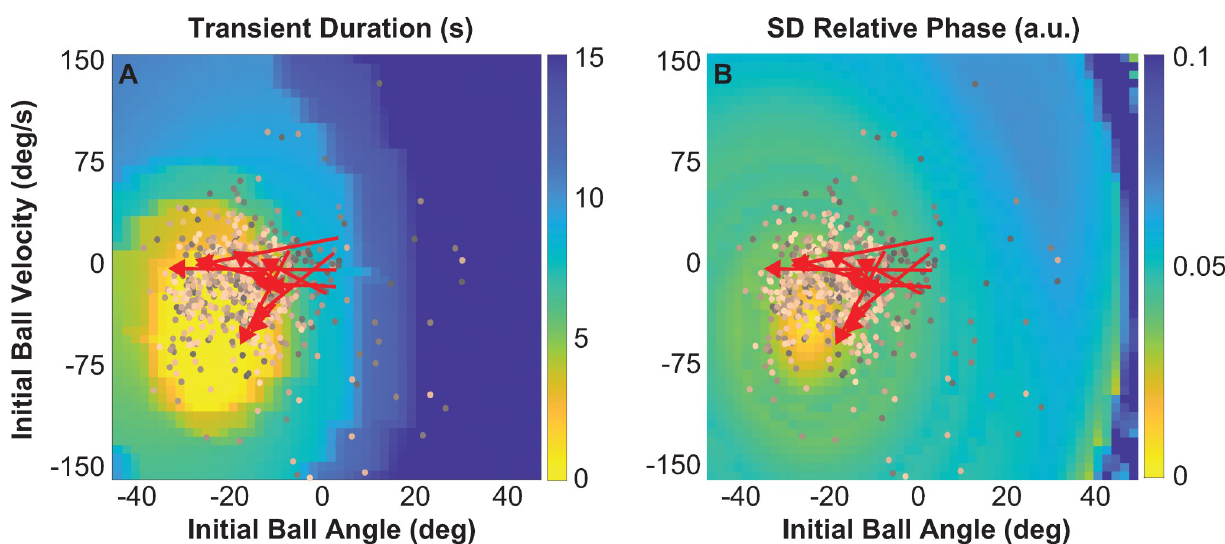
Fig 9. Predicted effect of initial ball states on transient duration and stability of the steady state: Simulated results for transient duration and variability of relative phase during steady state. The results were generated by forward simulations using an impedance controller for different initial ball angles and velocities; the impedance parameters were: K = 40 N/m and B = 40 Ns/m; cup frequency was fixed at 0.58 Hz. In the simulated maps experimental data of ball angles and velocities from all 1100 successful trials are overlaid; darker colors indicate early trials and lighter colors show later trials. For each subject, the means of the first 5 trials and the last 5 trials are connected and shown by red arrows. A. Simulated transient durations for different initial ball angles and velocities. B. Stability of steady state calculated as standard deviations of relative phase between cup and ball position.